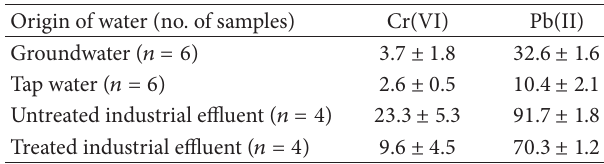
Table 4: Analytical results of Cr(VI) and Pb(II) ( 𝜇 g/L) in drinking water and industrial effluents (Denizli,